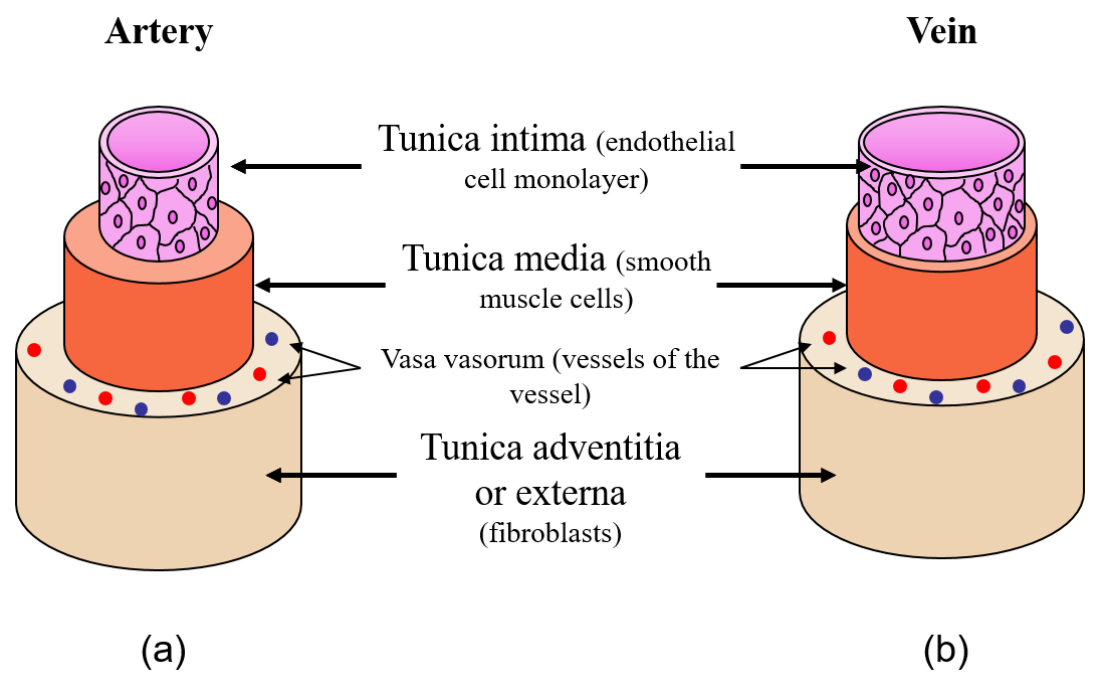
Figure 1. Schematized anatomy of vascular conduits. A schema of the arteries’ anatomy is presented on ( a ), and the anatomy of veins is presented on ( b ).